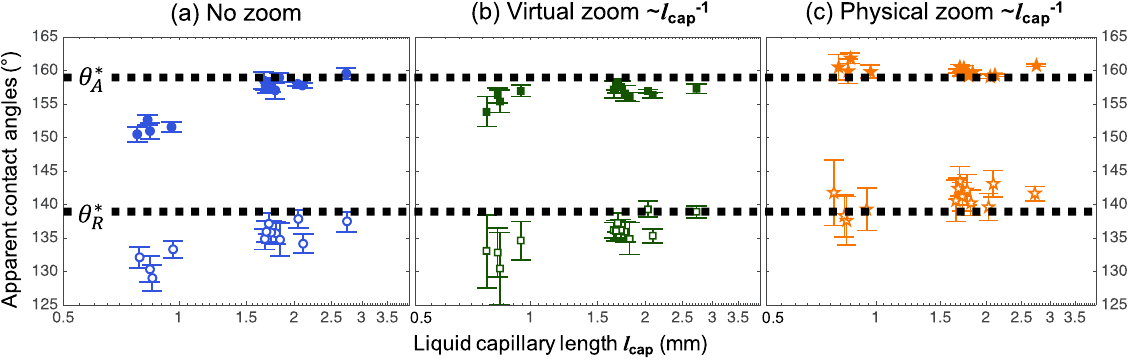
Figure 5. Contact angles of 13 different liquids measured on a superomniphobic SiO 2 surface at different zooms with the accurate values shown as the horizontal dotted lines. ( a ) With no zoom, liquids with very small capillary lengths (fluorinated solvents) show deviations with their contact angles consistently underestimated. ( b ) Virtual zoom helps mitigating the deviation without readjusting the experiment setups. ( c ) With physical zoom and the proposed rule, the contact angles are obtained with a consistent accuracy regardless of the liquids. The dashed lines indicate the apparent contact angles measured with physical zoom and are drawn as visual guides for comparison with ( a ) and ( b